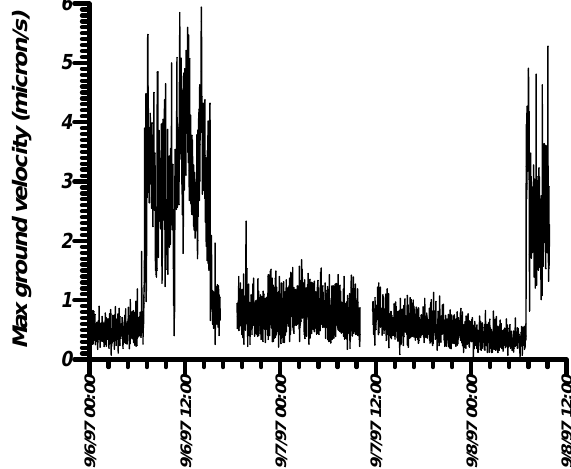
FIG. 3. Saturday, September 6–Monday, September 8, 1997 record of maximum vertical ground velocity at the E4R